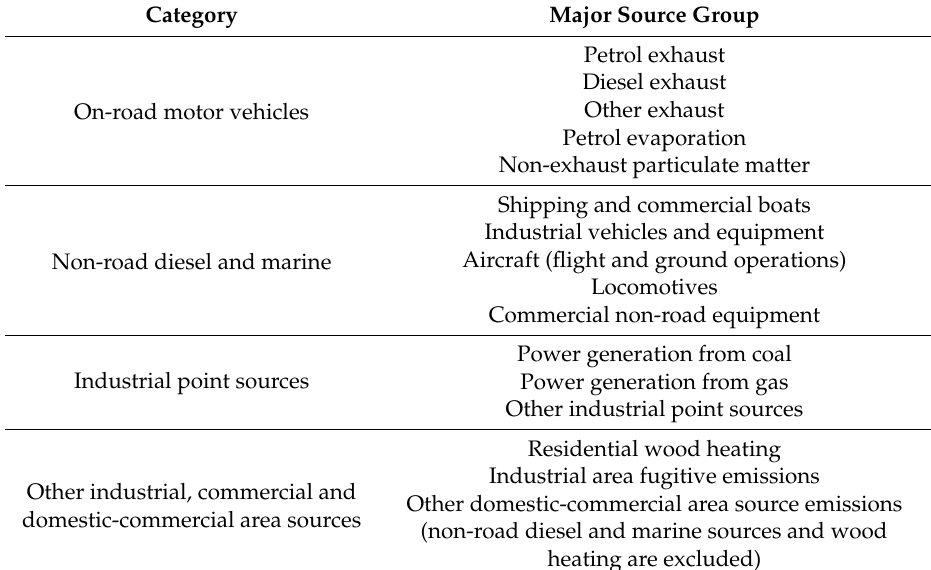
Table 1. The 16 major source groups segregated from the 2008 NSW GMR emission